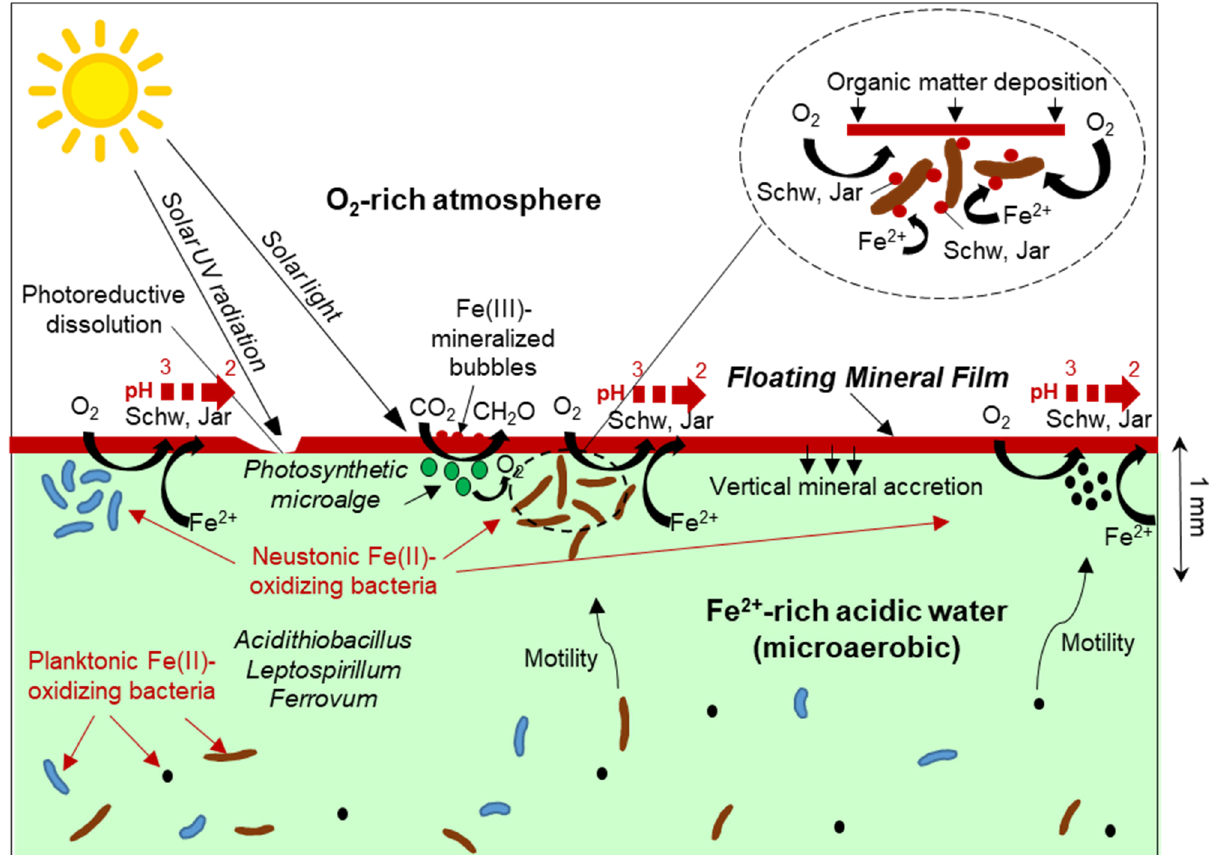
Figure 9. Schematic representation of metal/microbe/mineral interactions leading to Fe(III)-rich floating mineral film formation in acid mine drainage settings. The inset shows a magnification of Fe(II)-oxidizing bacteria inhabiting the surface microlayer and catalyzing the precipitation of Fe(III) minerals at or near the cell wall. Schw: Schwertmannite, Jar: jarosite.